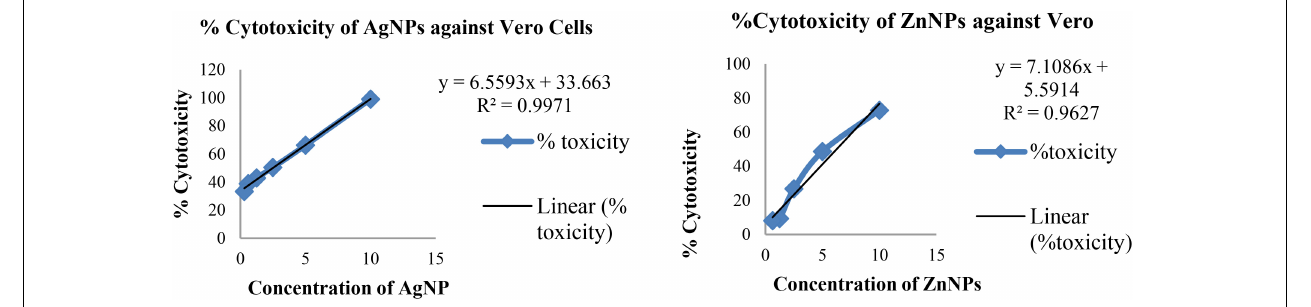
FIGURE 7 | Plot of cytotoxicity vs concentration of nanoparticles.